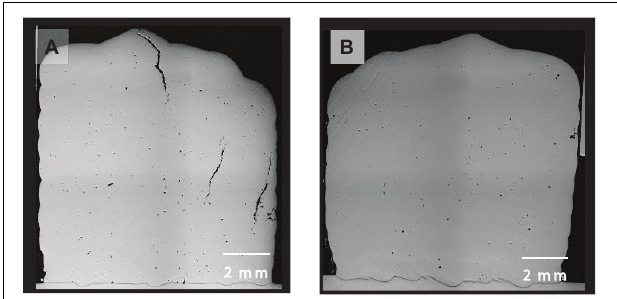
FIGURE 4 | Micrograph images of sample cross-sections of B samples produced at room temperature (RT; (A) ) and 450 ◦ C (B) pre-heating temperature showing cracks in build direction at RT and no cracks at 450 ◦